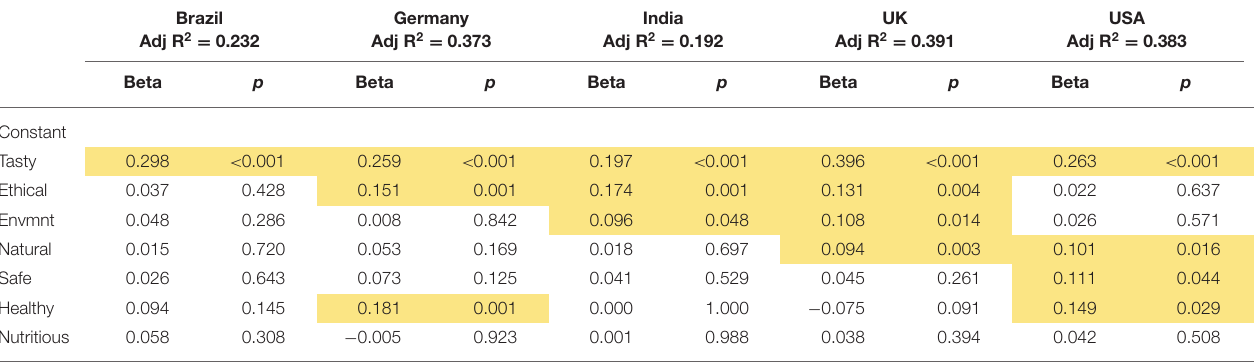
TABLE 3 | Regression models showing product characteristic predictors (standardised β ) of intention to purchase animal-free dairy cheese in Brazil, Germany, India, the UK and the